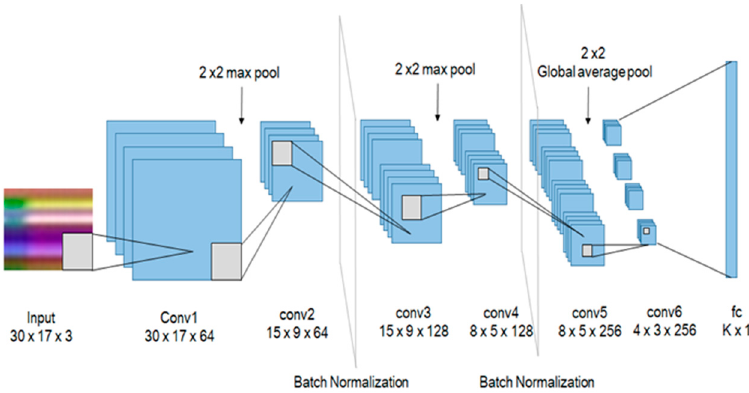
Figure 5. The proposed convolutional neural network (CNN) structure.